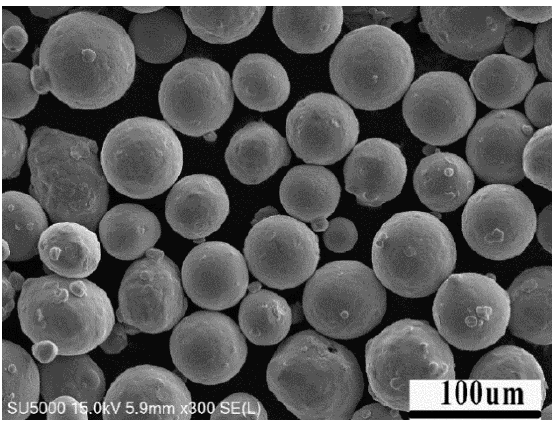
Figure 1. SEM morphology of Ti-6Al-4V powder. Table 1. Ti-6Al-4V alloy powder chemical composition standard requirements and measured